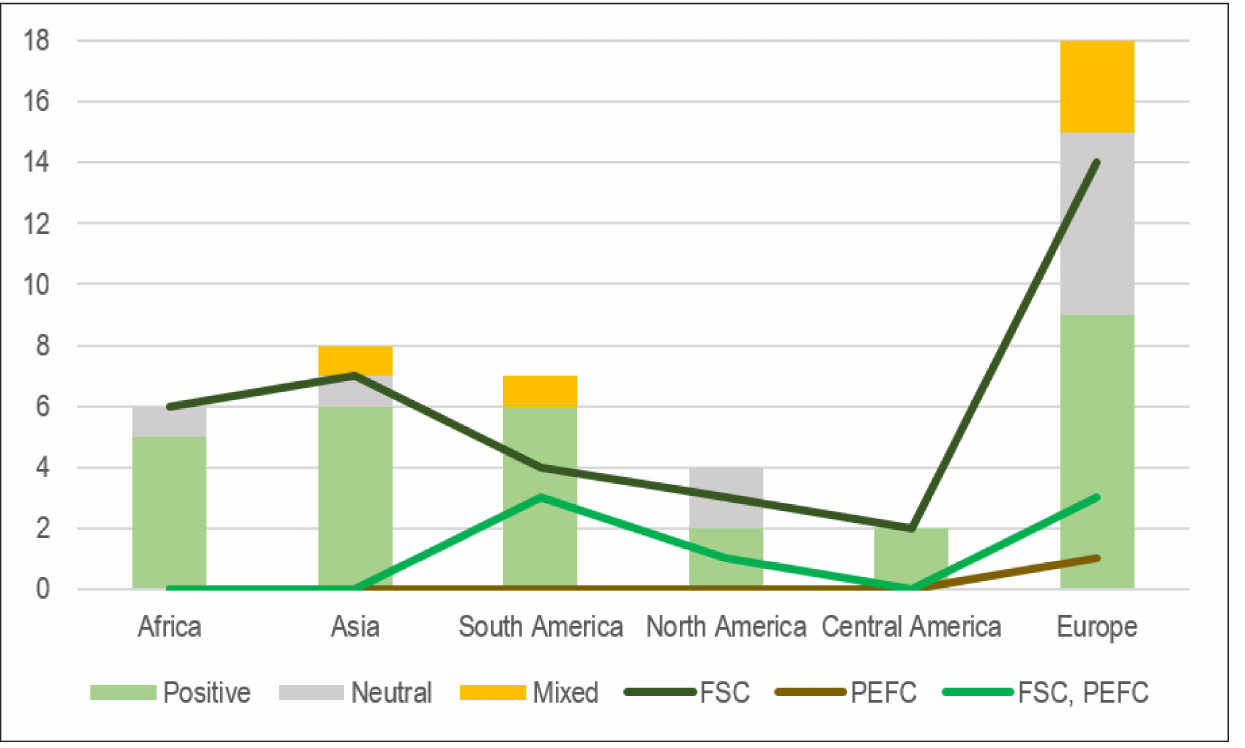
Figure A3. Distribution of empirical studies on forest degradation, illustrated by impact and certifi- cation